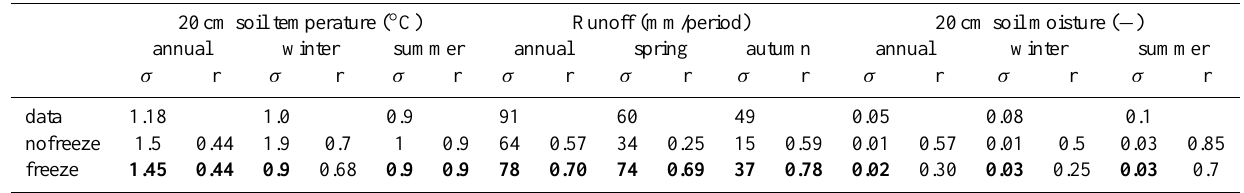
Table 4. Standard deviation σ and correlation coefficient r between model (FREEZE, thermodynamical) and data for the 20cm soil tem- perature, runoff and 20cm soil moisture over the 18yrs of simulations and data available at Valdai. For each time period, the statistics are computed using the modeled or observed value averaged over the time period. The statistics improved by the use of the soil freezing module are